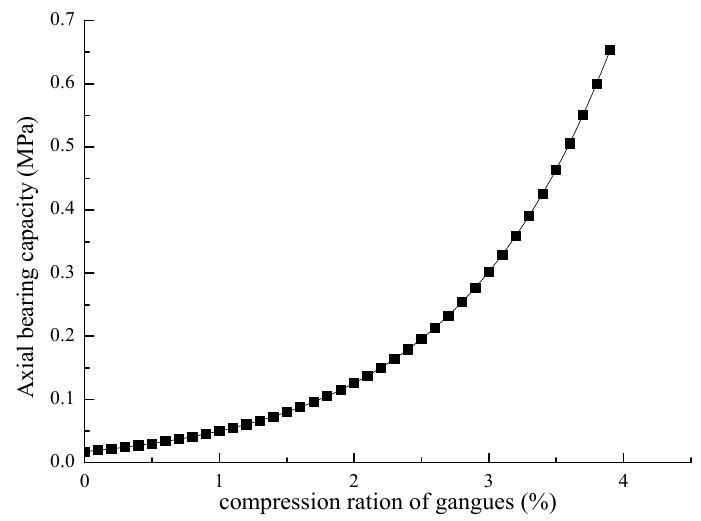
Figure 9. Curve relating bearing capacity to compression ratio of rubble in gob.